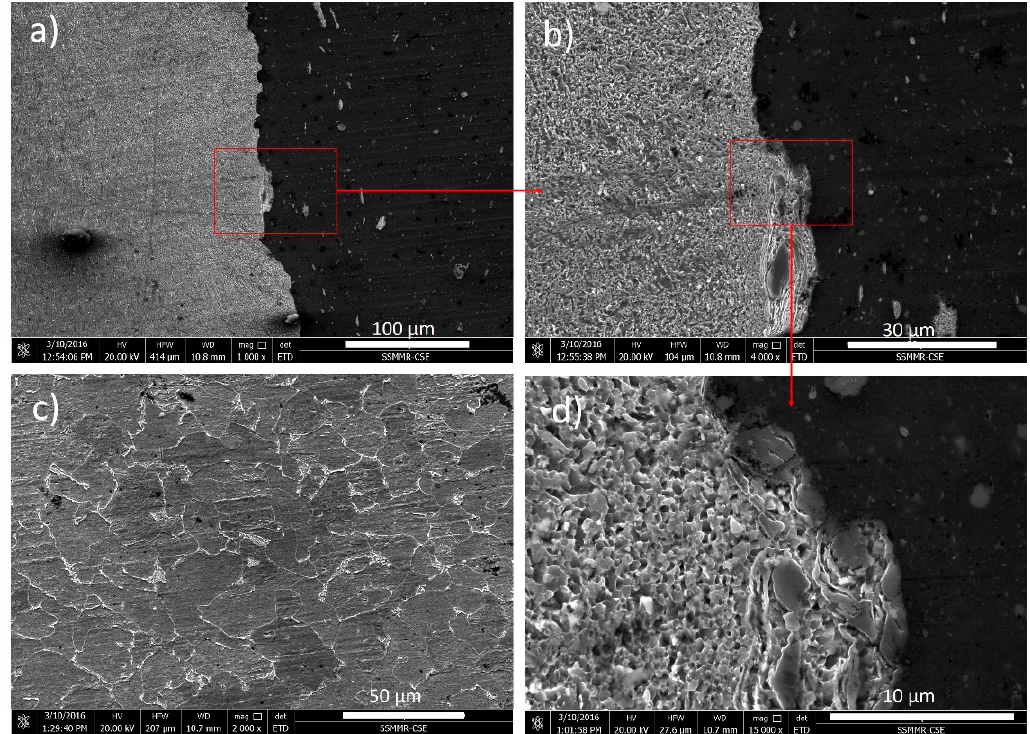
Figure 6. SEM micrographs for the FSWed joint produced at 200 rpm and 50 mm/min showing different magnifications at the interface between Al and steel in ( a ), ( b ) and ( d ); ( c ) SEM image for the base material.